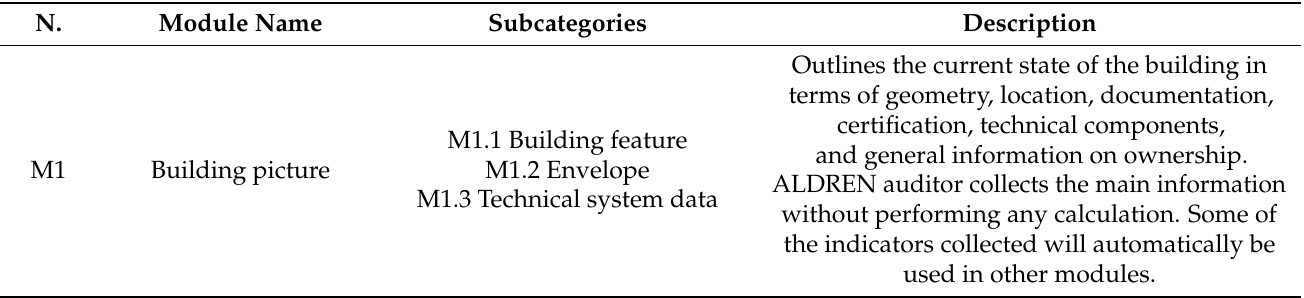
Table 3. Definition of the six ALDREN BuildLog